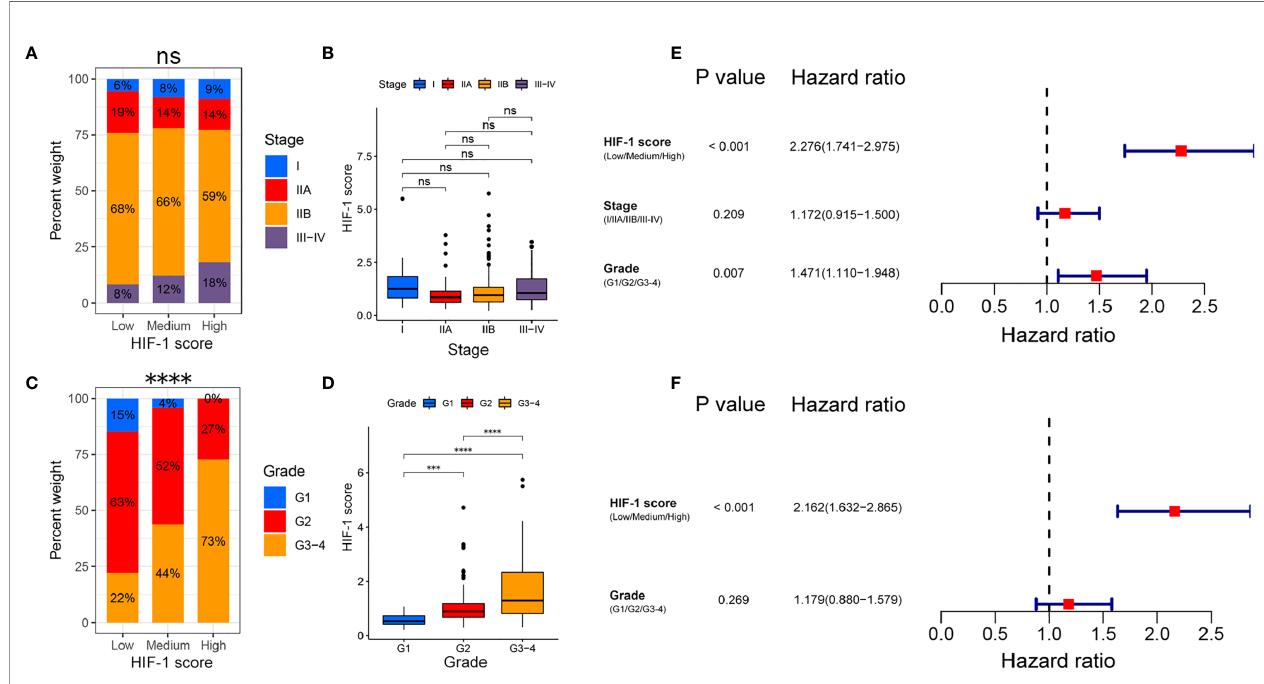
FIGURE 4 | Association between the HIF-1 score and clinicopathological characteristics in PDAC. (A, B) No signi fi cant association between HIF-1 score and AJCC stage were found in PDAC. (C, D) Signi fi cant positive correlation between HIF-1 score and histologic grade were observed in PDAC. (E) Univariate Cox regression analysis demonstrated that HIF-1 score system and histologic grade were prognostic factor for OS of patients with PDAC. (F) Multivariate Cox regression analysis demonstrated that the HIF-1 score system was an independent unfavorable prognostic factor for OS of patients with PDAC. PDAC, pancreatic ductal adenocarcinoma; OS, overall survival. ns > 0.05; ***P value < 0.001; ****P value <